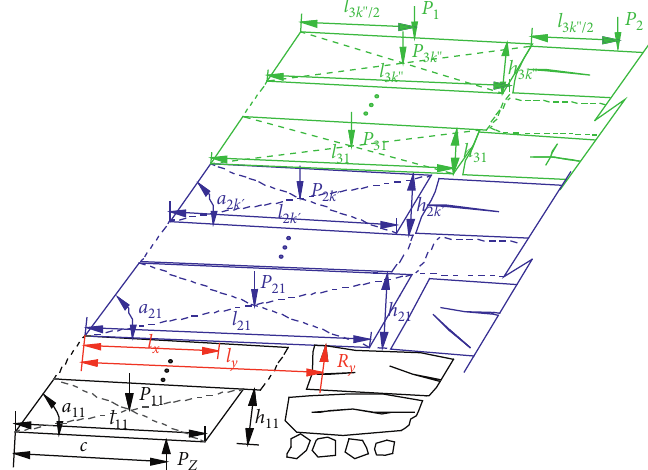
Figure 11: Rock movement characteristics under the hinged roof